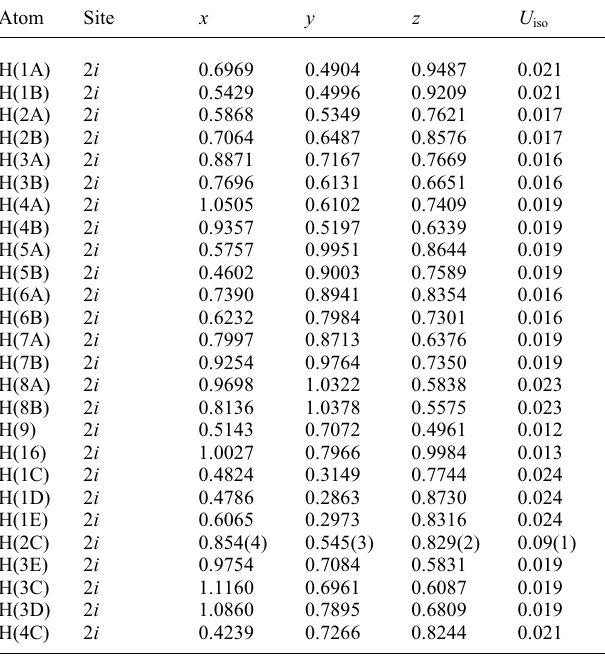
Table 2. Atomic coordinates and displacement parameters (in Å 2 )